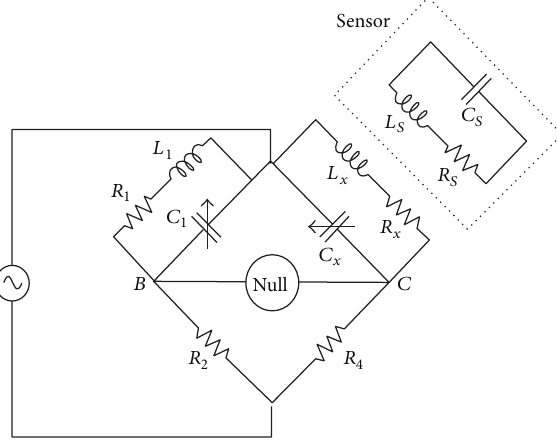
Figure 5: Maxwell-Wien circuit variation proposed for energy and data